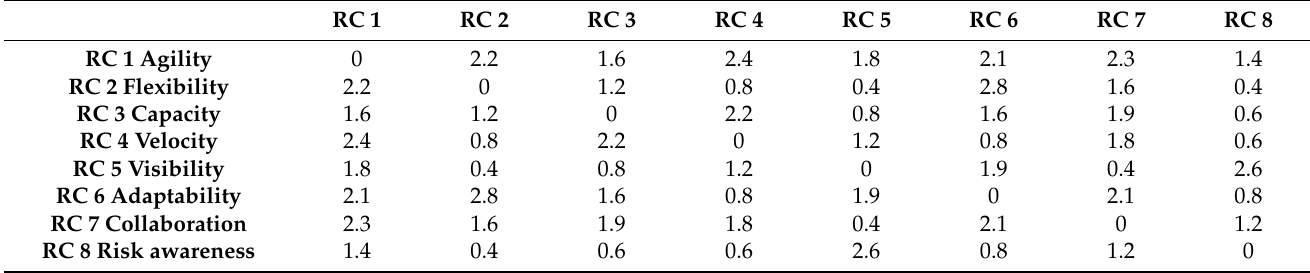
Table 5. Correlation matrix of key RCs (C M